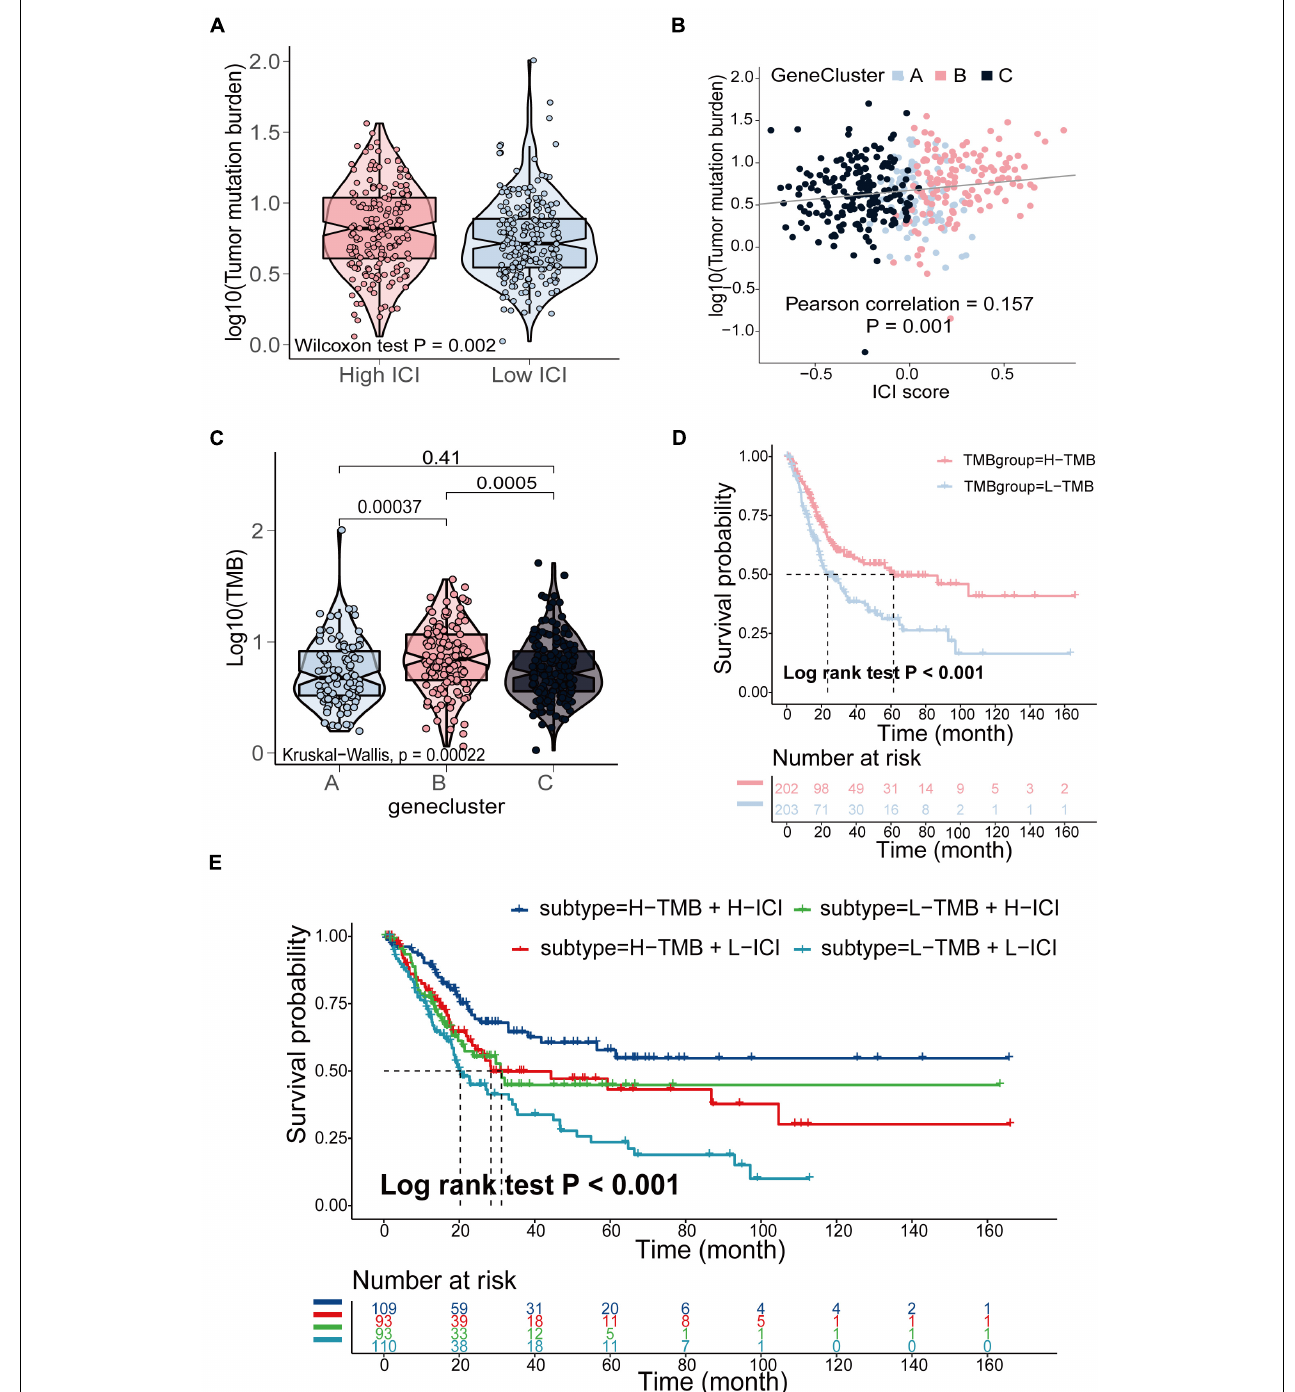
FIGURE 4 | The relationship between the ICI score and somatic mutation in the TCGA- BLCA cohort. (A) TMB difference in the high and low ICI score subgroups (Wilcoxon test, p = 0.002). (B) Pearson correlation analysis between ICI score and mutation load (Pearson correlation coefficient = 0.157, p = 0.001). (C) The comparison of TMB among three gene clusters (Kruskal–Wallis test, p = 0.0002). (D) Kaplan–Meier curves for high and low TMB groups of (log-rank test, p < 0.001). (E) Kaplan–Meier curves for patients stratified by both TMB and ICI score (log-rank test, p < 0.001).